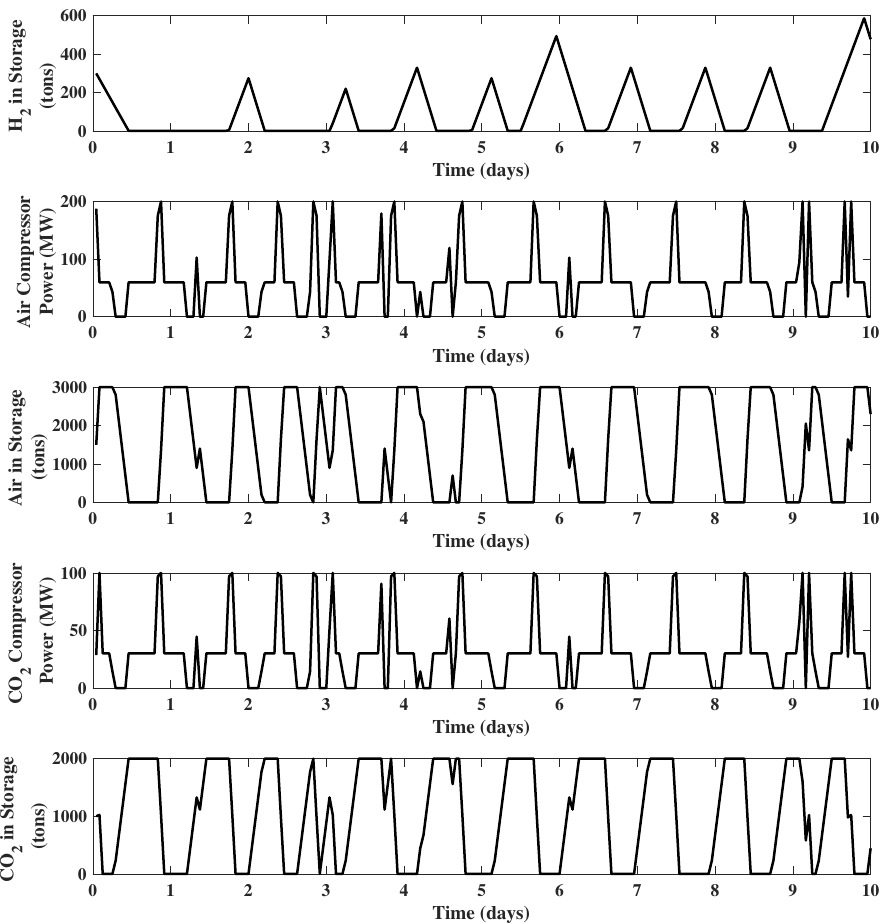
Figure 7. Closed-loop simulation of EMPC using a 24 h prediction horizon for Example